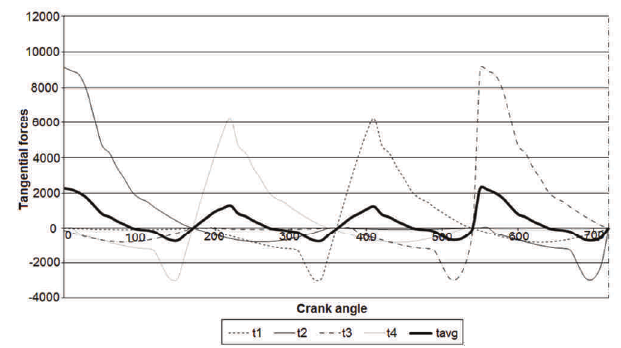
Fig. 2. Crank pin effort – no burning in two cylinders